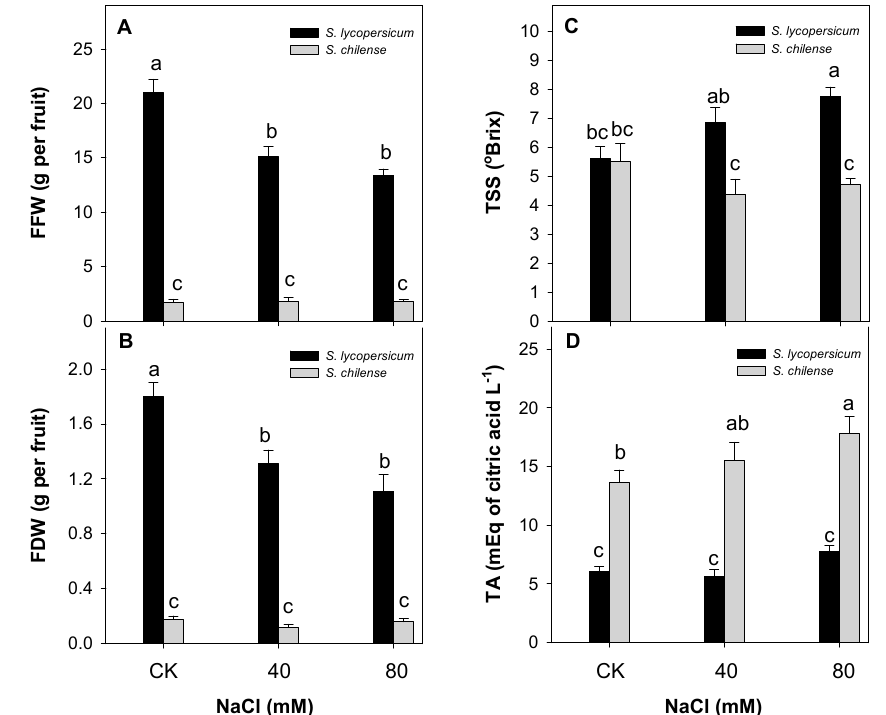
Figure 1. Fruit fresh weight (FFW; ( A )), fruit dry weight (FDW; ( B )) (g per fruit), total soluble solid (TSS, ◦ Brix; ( C )) and titratable acidity (TA, mEq of citric acid L − 1 ; ( D )) in two species of tomato (domesticated Solanum lycopersicum and wild-relative Solanum chilense ) cultivated for 112 days in nutrient solution containing 0 (control treatment, CK), 40 or 80 mM NaCl. Each value represents the mean ± SE ( n = 6). Lower-case letters indicate differences ( p ≤ 0.05, Duncan test) between treatments and species.